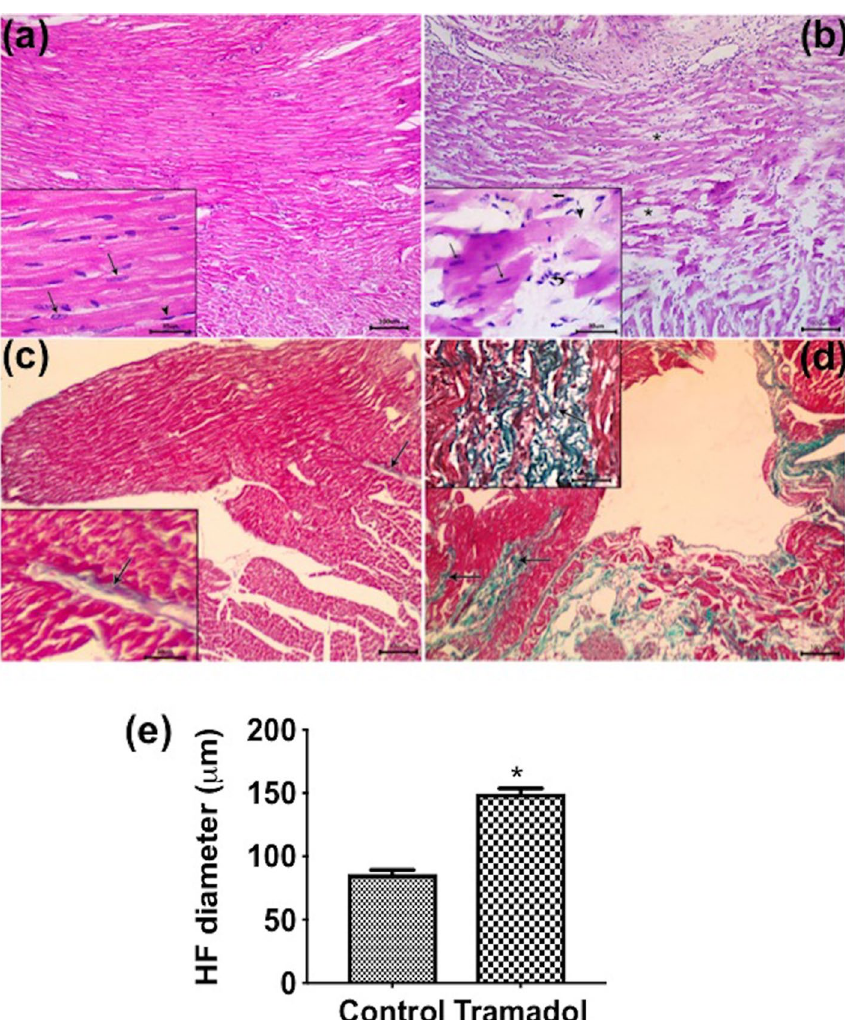
Figure 2. Photomicrographs of a longitudinal section of cardiac muscles stained with hematoxylin and eosin (×100; insets ×400). ( a ) Control group showing branching and anatomizing muscle fibers with central oval vesicular nuclei (arrows in inset) and acidophilic sarcoplasm. The flat nuclei of fibroblasts (arrowhead in inset) are also seen in the interstitial spaces between muscle fibers. ( b ) Tramadol treated group showing separation of cardiac fibers with increased interstitial spaces between them (asterisk). Discontinuity (arrowhead in inset), degeneration (thick arrow in inset), and darkly stained nuclei (arrows in inset) are evident in some muscle fibers. Mononuclear cell infiltration (curved arrow in inset) is also seen between affected widely spaced cardiac muscle fibers. Photomicrographs of a longitudinal section of cardiac muscles stained with Masson’s trichrome (×100; insets ×400). ( c ) Control group showing scanty collagen fibers in the interstitial space between muscle fibers (arrows). ( d ) Tramadol treated group showing a marked increase in collagen fibers in the interstitial space between muscle fibers (arrows). ( e ) Heart fiber diameter in control and tramadol mice. n = 10. Data are expressed as the means ± SEM, *p < 0.05 for control versus